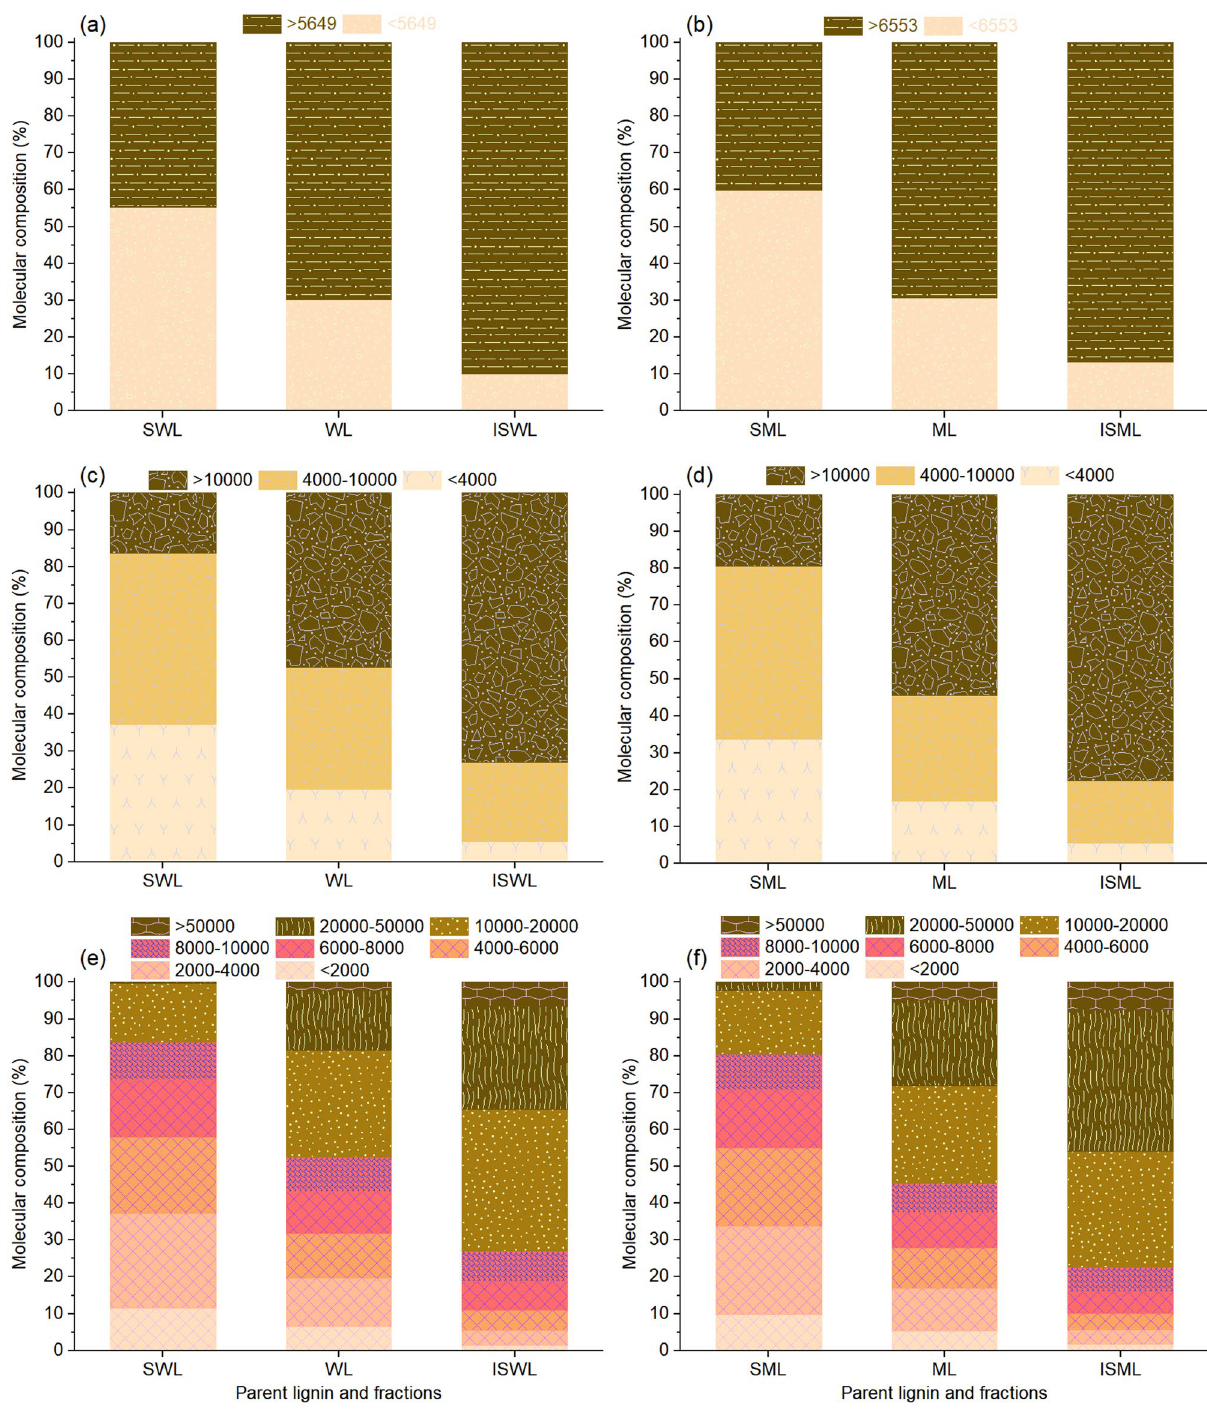
Figure 2. Molecular composition of the parent lignin and the fractions under different molecular intervals: WL, SWL, and ISWL under ( a ) 2, ( c ) 3, and ( e ) 8 intervals; ML, SML, and ISML under ( b ) 2, ( d ) 3, and ( f ) 8